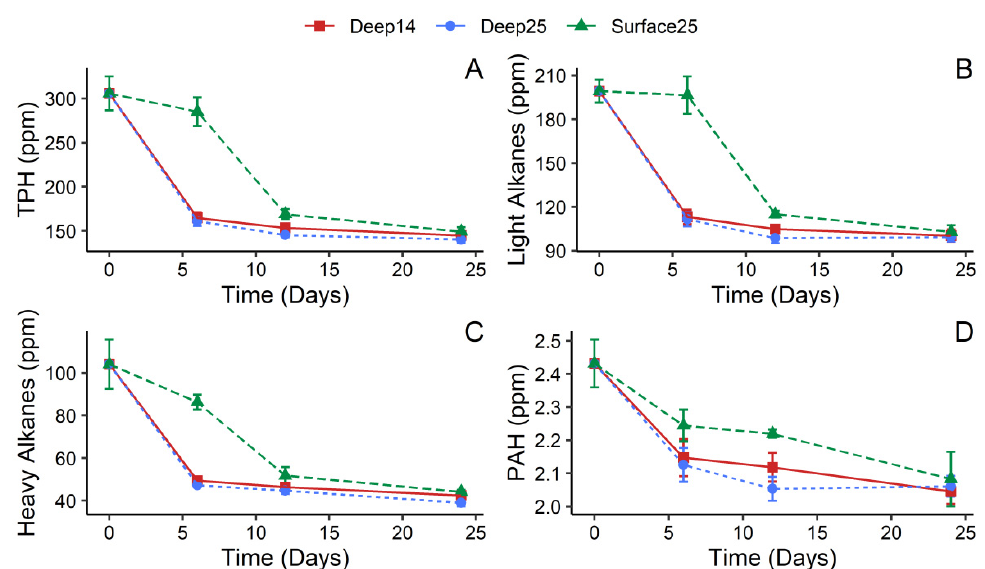
Figure 1. Hydrocarbon biodegradation over time for the Deep14, Deep25 and Surface25 treatments for ( A ) total petroleum hydrocarbons (TPH), ( B ) light alkanes (C 14 -C 25 ), ( C ) heavy alkanes (C 26 -C 35 ) and ( D ) PAHs. Values on the y -axis correspond to the concentration range of each hydrocarbon group to aid visualisation. Error bars represent the standard deviation ( n = 3).